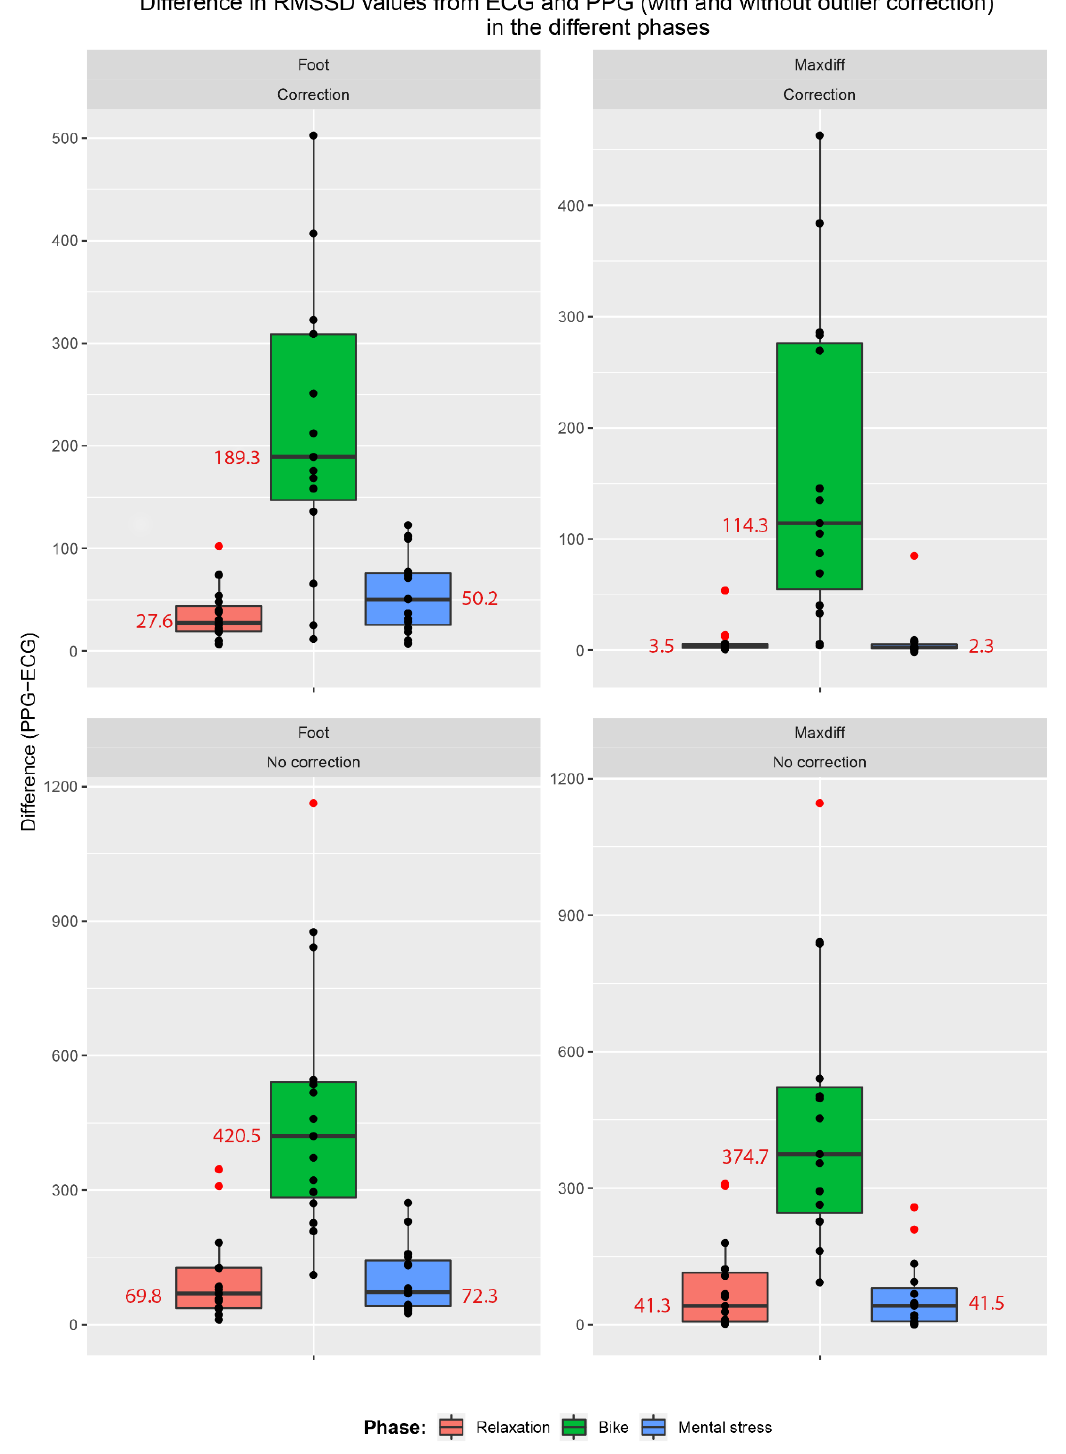
Figure 10. The difference between RMSSD values as calculated from PPG and ECG for the 15 participants in the different phases. Grouped by fiducial point and outlier correction. Outliers and median values are shown in